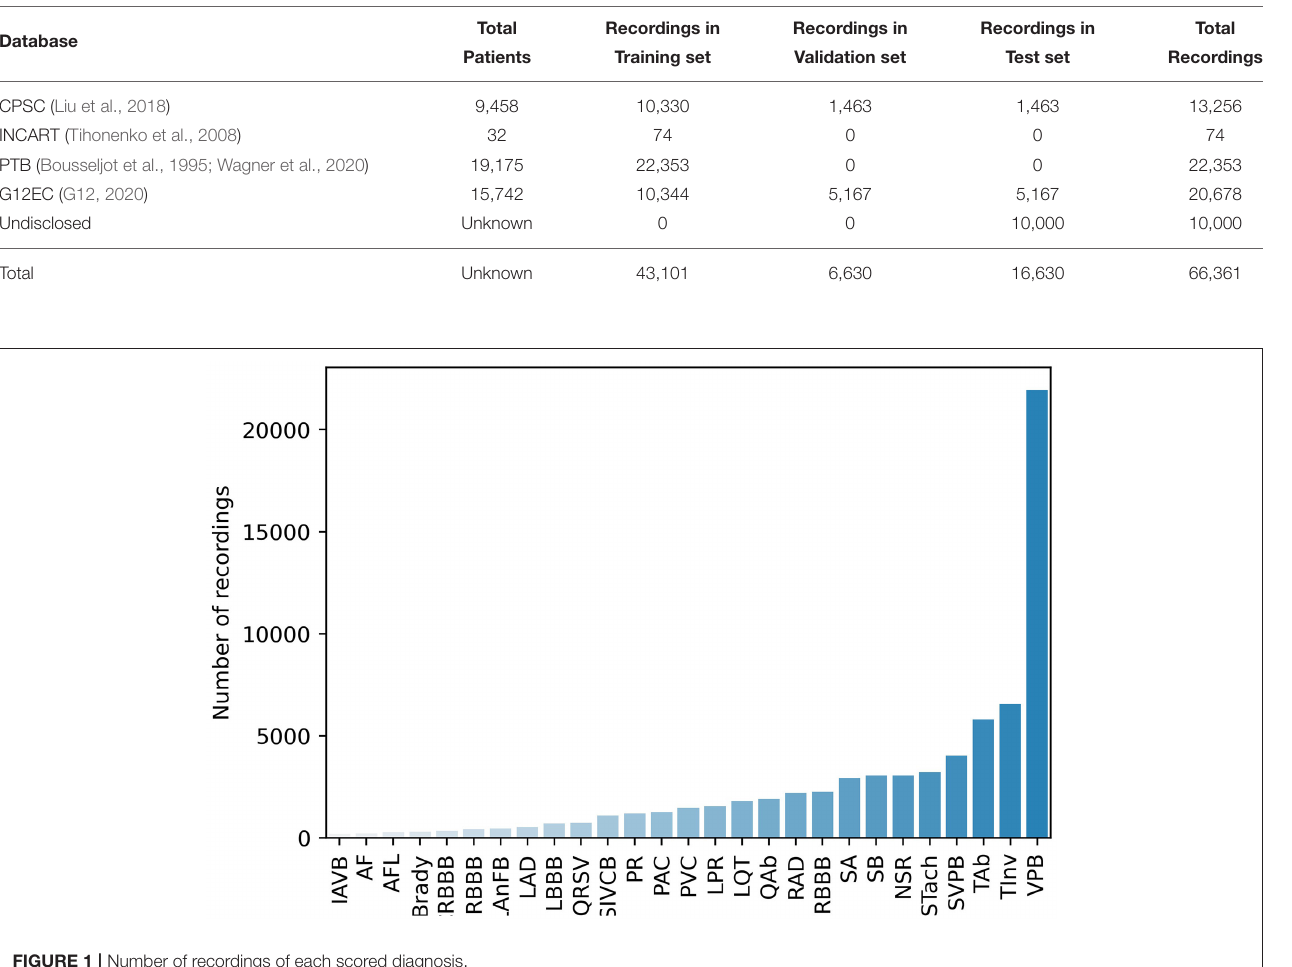
TABLE 1 | Overview of databases used in Challenge 2020.